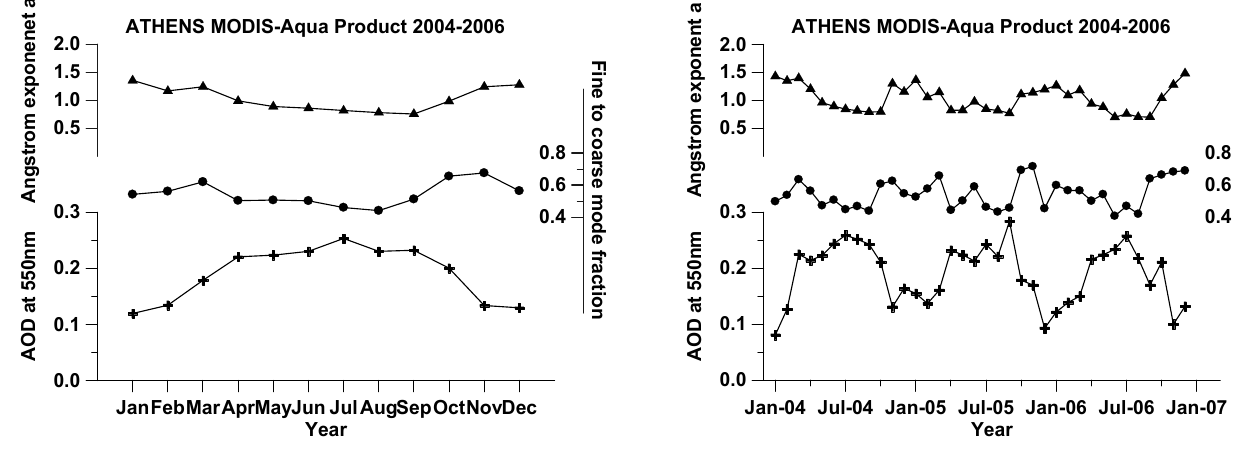
Fig. 7. Temporal evolution of the AE and AOD (left) and the corresponding monthly means of the AE, AOD and the fine to coarse mode fraction of aerosols (right). The data were obtained from MODIS over Athens for the three-year period (January 2004–December